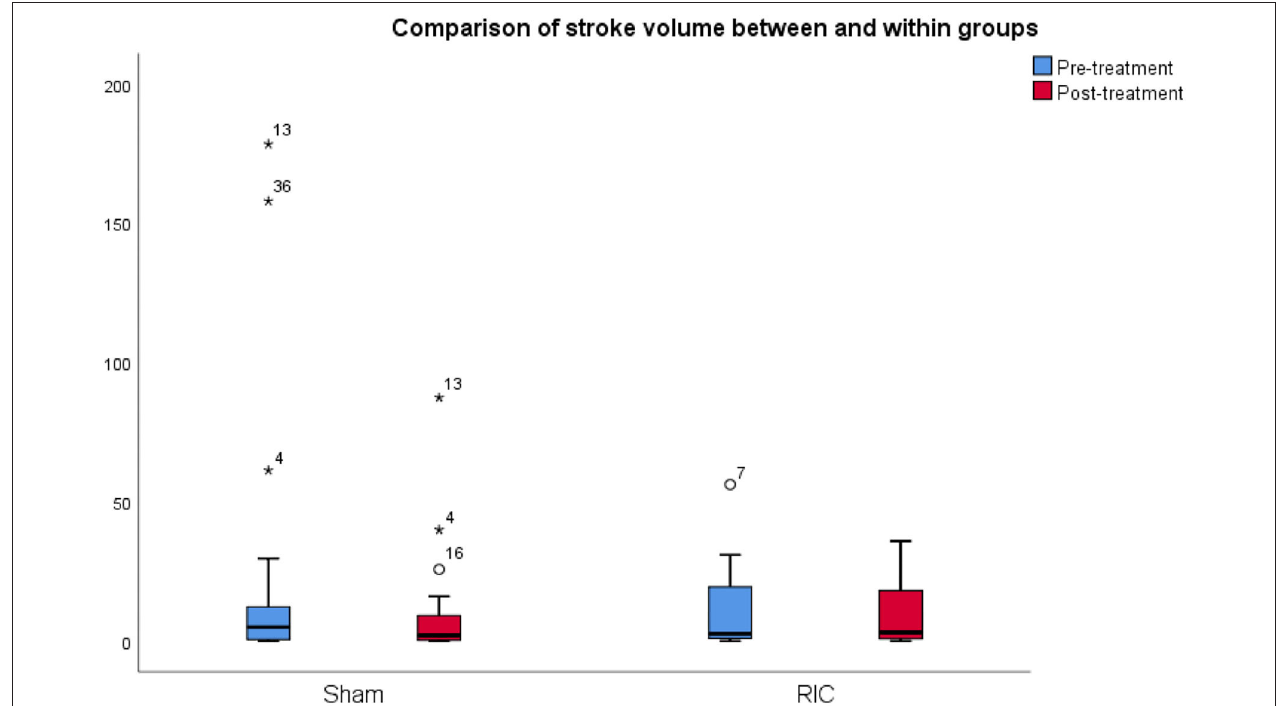
FIGURE 2 | Comparison of infarct volume between and within groups. The mean infarct volume on CT at baseline and 6 months after stroke in the sham group and the RIC group. The median difference of the final infarct volume at 6 months compared to baseline was slightly larger in the sham group, but these results did not reach statistical significance ( p = 0.4). One of the reasons for a better outcome in terms of stroke volume in the sham group might be the larger infarct volumes at admission as compared to the experimental group.